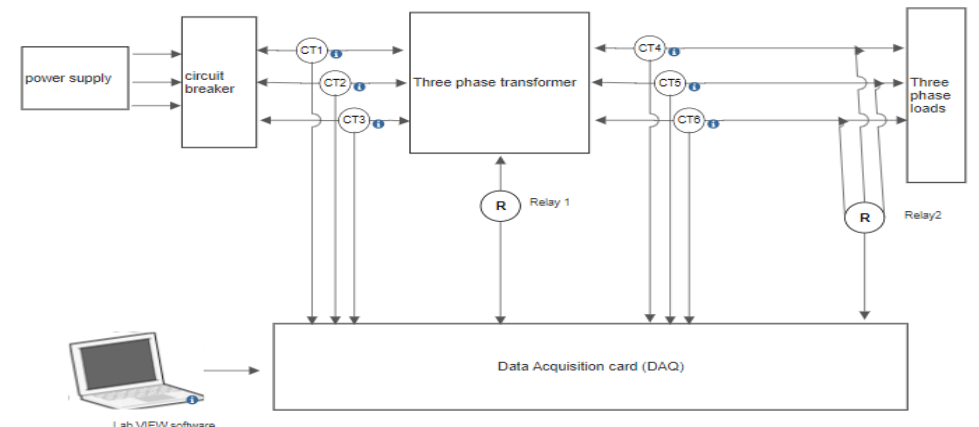
Figure 1. Schematic of the system in the lab .